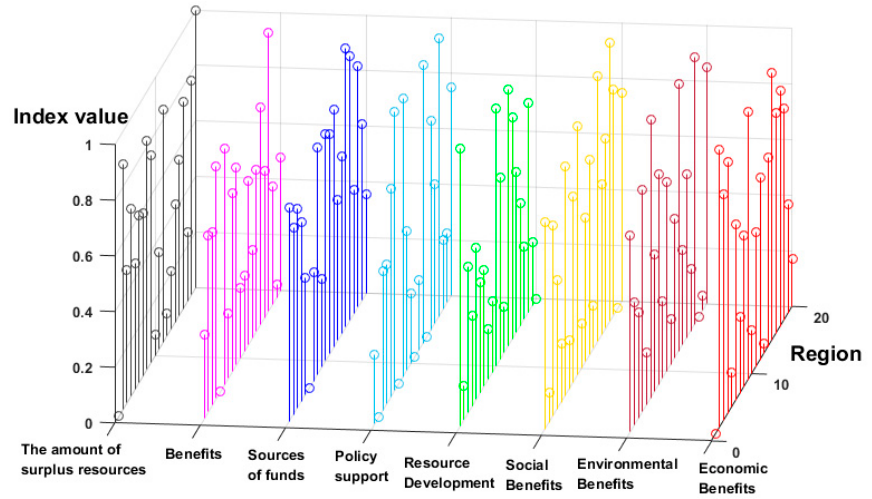
Figure 6. Value of commonality indexes of wind power generation (WG) in 20 regions.